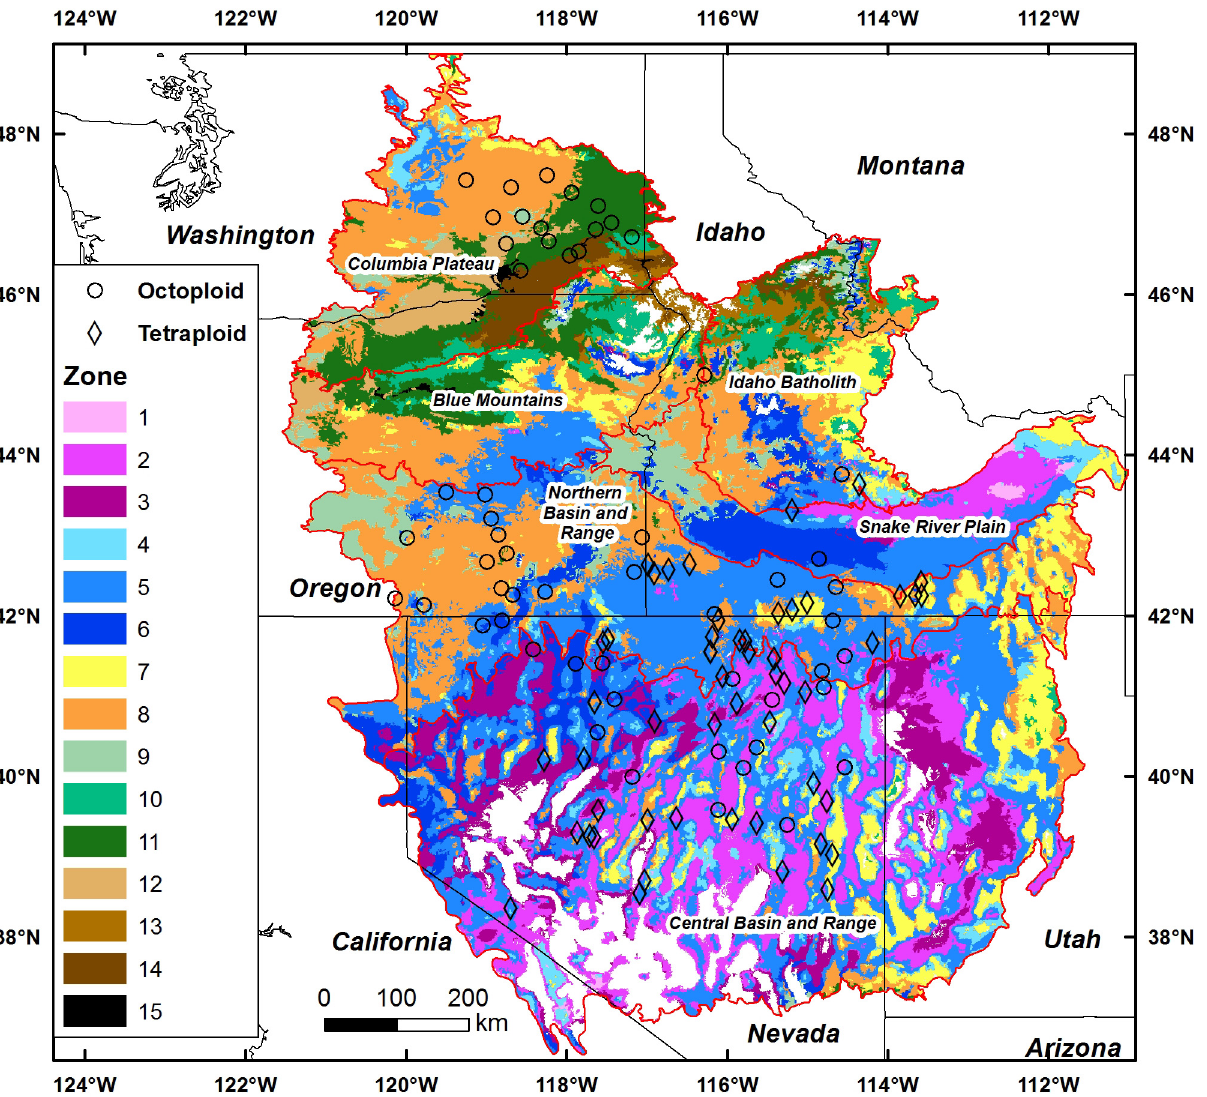
Fig 2. Fifteen proposed seed zones for basin wildrye based on regression models of canonical variates 1 and 2 with climate variables over intermountain west. The canonical variates were derived from canonical correlation of plant traits and climate variables. Ecoregion boundaries are shown as red lines. Model predictions outside the range of observed canonical scores were not mapped, and were shown in